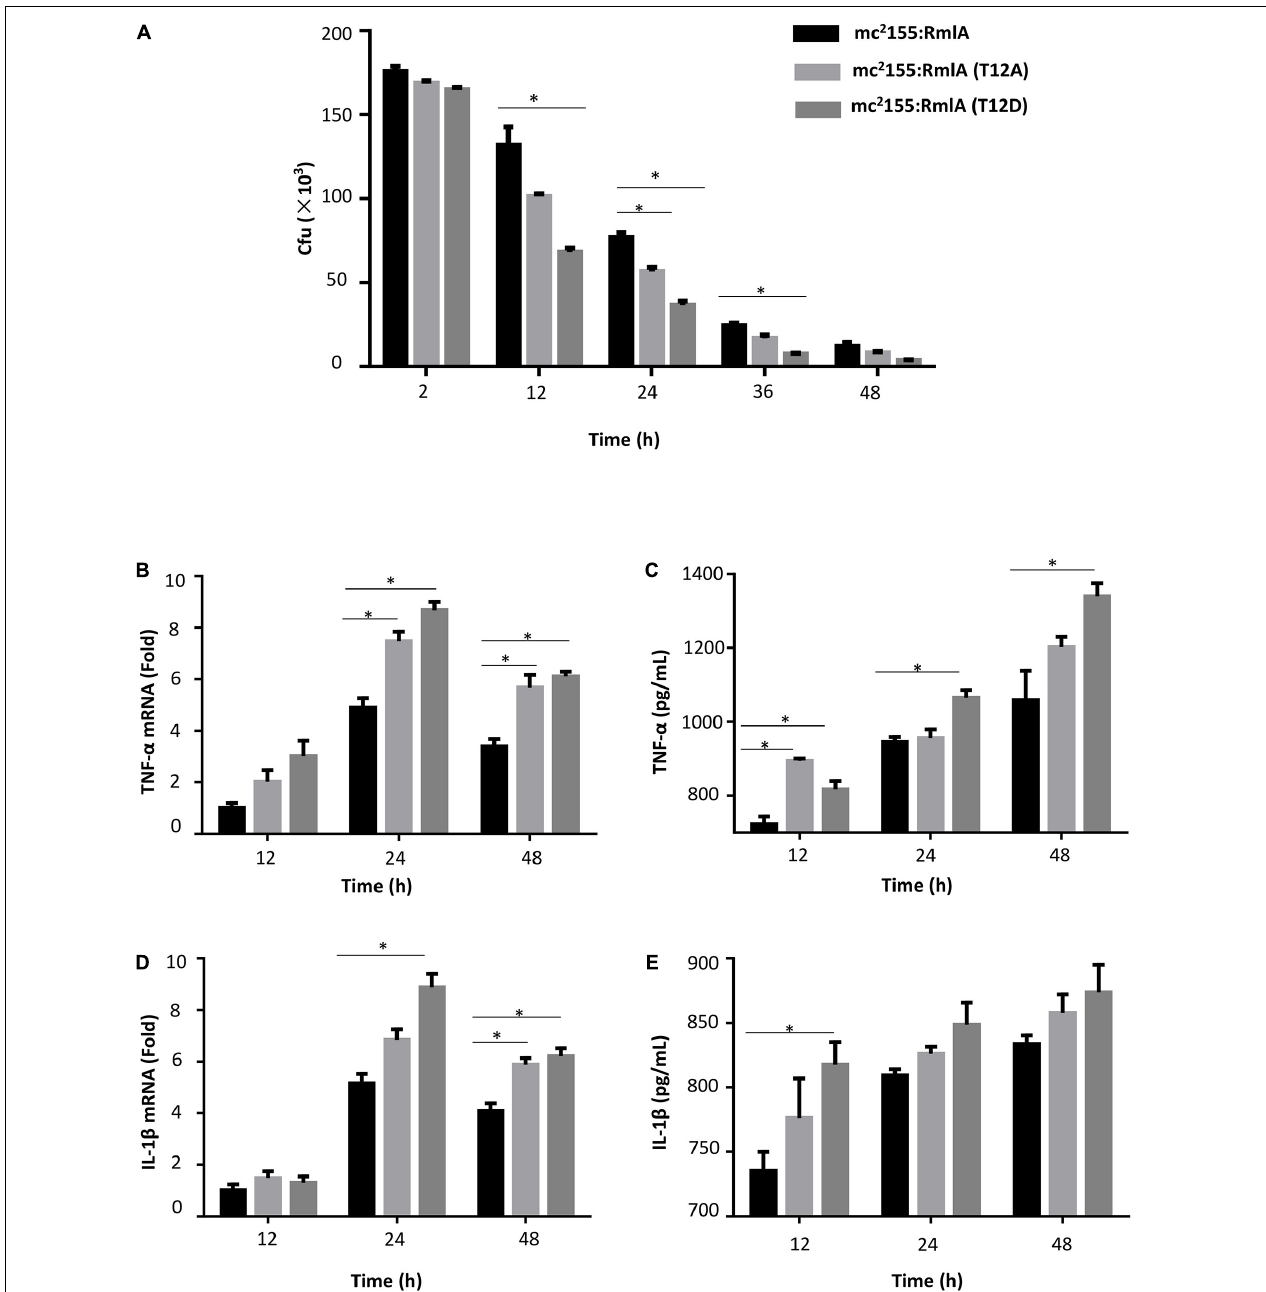
FIGURE 7 | Macrophage infection with M. smegmatis RmlA mutants. (A) Survival of wild type and mutants of RmlA in primary human monocyte–derived macrophage THP-1 with a series of time points. The experiment was performed in triplicates ( n = 3). Error bars indicate standard error of mean. Asterisk indicates significant difference ( P < 0.05). (B) Quantitative PCR analysis of TNF- α mRNA level in THP-1 macrophages infected for 12–48 h with wild-type M. smegmatis or RmlA mutant M. smegmatis . (C) ELISA analysis of TNF- α expression in supernatants of THP-1 macrophages for 12–48 h with wild-type M. smegmatis or RmlA mutant M. smegmatis . (D) Quantitative PCR analysis of IL-1 β mRNA in THP-1 macrophages infected for 12–48 h with wild-type M. smegmatis or RmlA mutant M. smegmatis . (E) ELISA analysis of IL-1 β expression in supernatants of THP-1 macrophages for 12–48 h with wild-type M. smegmatis or RmlA mutant M. smegmatis